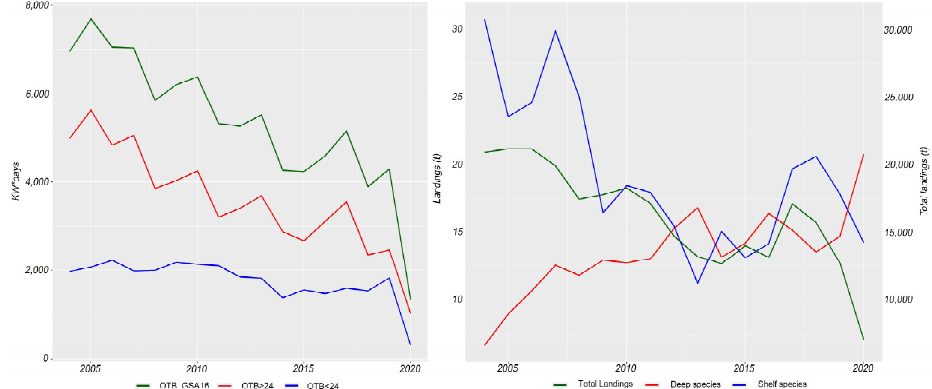
Figure 8. ( Left ): nominal fishing effort (kw*fishing days) of bottom trawlers registered in GSA 16 (DCF source) over the years; ( right ): landing trend expressed in tons over the years .